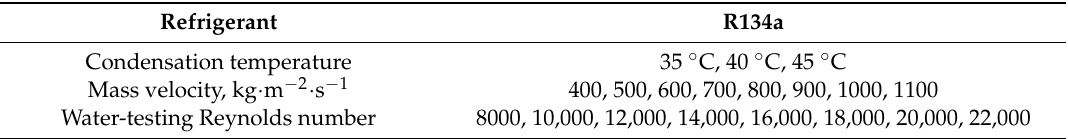
Table 4. Working conditions of the